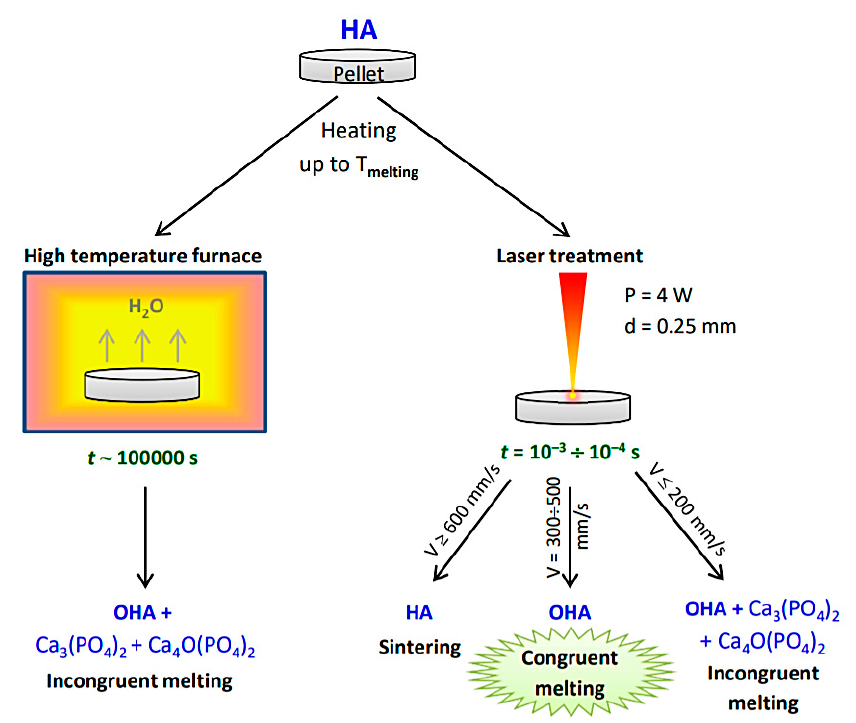
Figure 8. Comparison of options for high-temperature treatment of the HA pellets. P, laser power; d, laser spot diameter; V, scanning speed; t, duration of treatment; HA, hydroxyapatite; OHA, oxyhydroxyapatite.